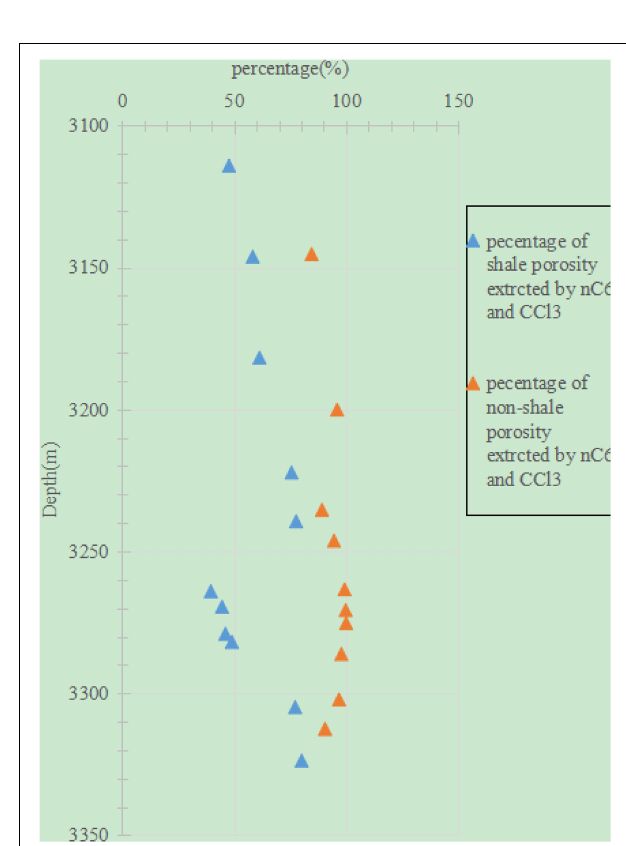
FIGURE 10 | Porosity of the mud shale samples versus the non-mud shale after sequential extraction with nC 6 + CHCl 3